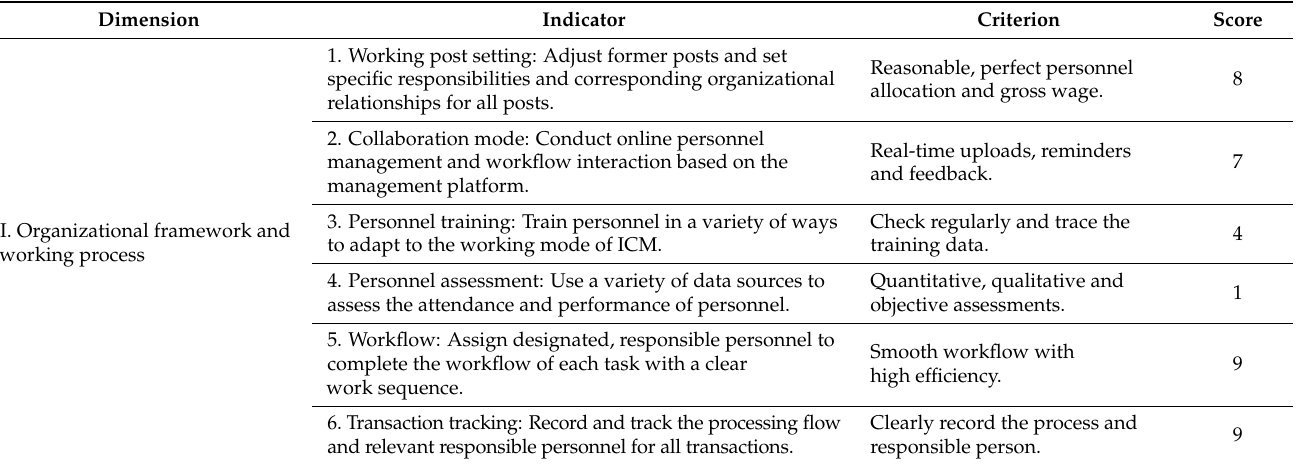
Table A1. The maturity scoring table for